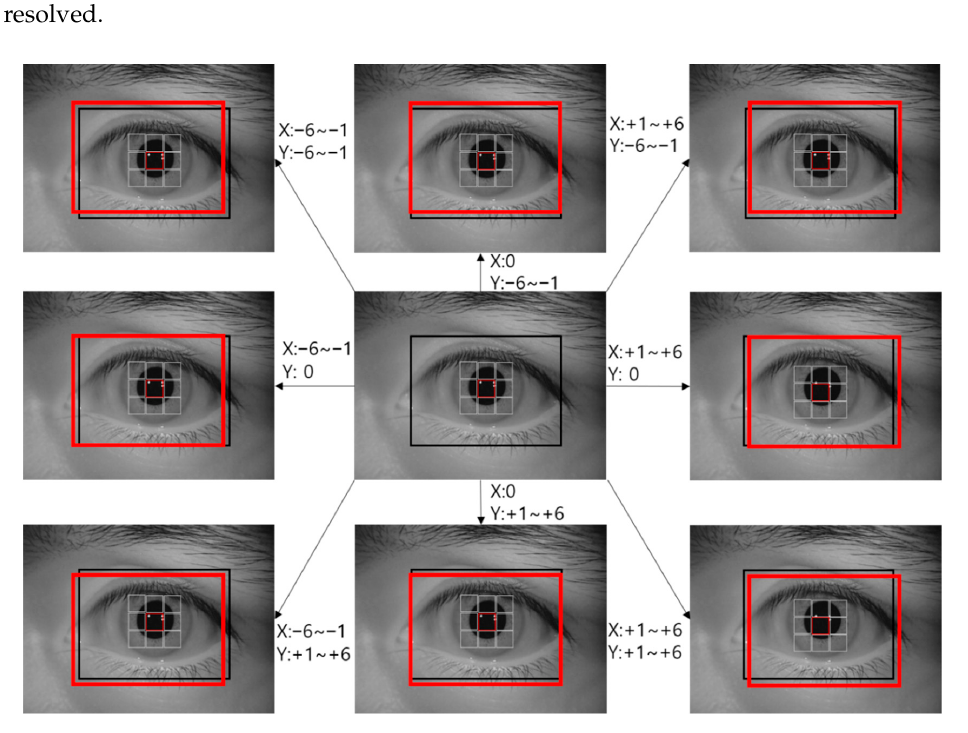
Figure 6. Example of data augmentation process used in this study.